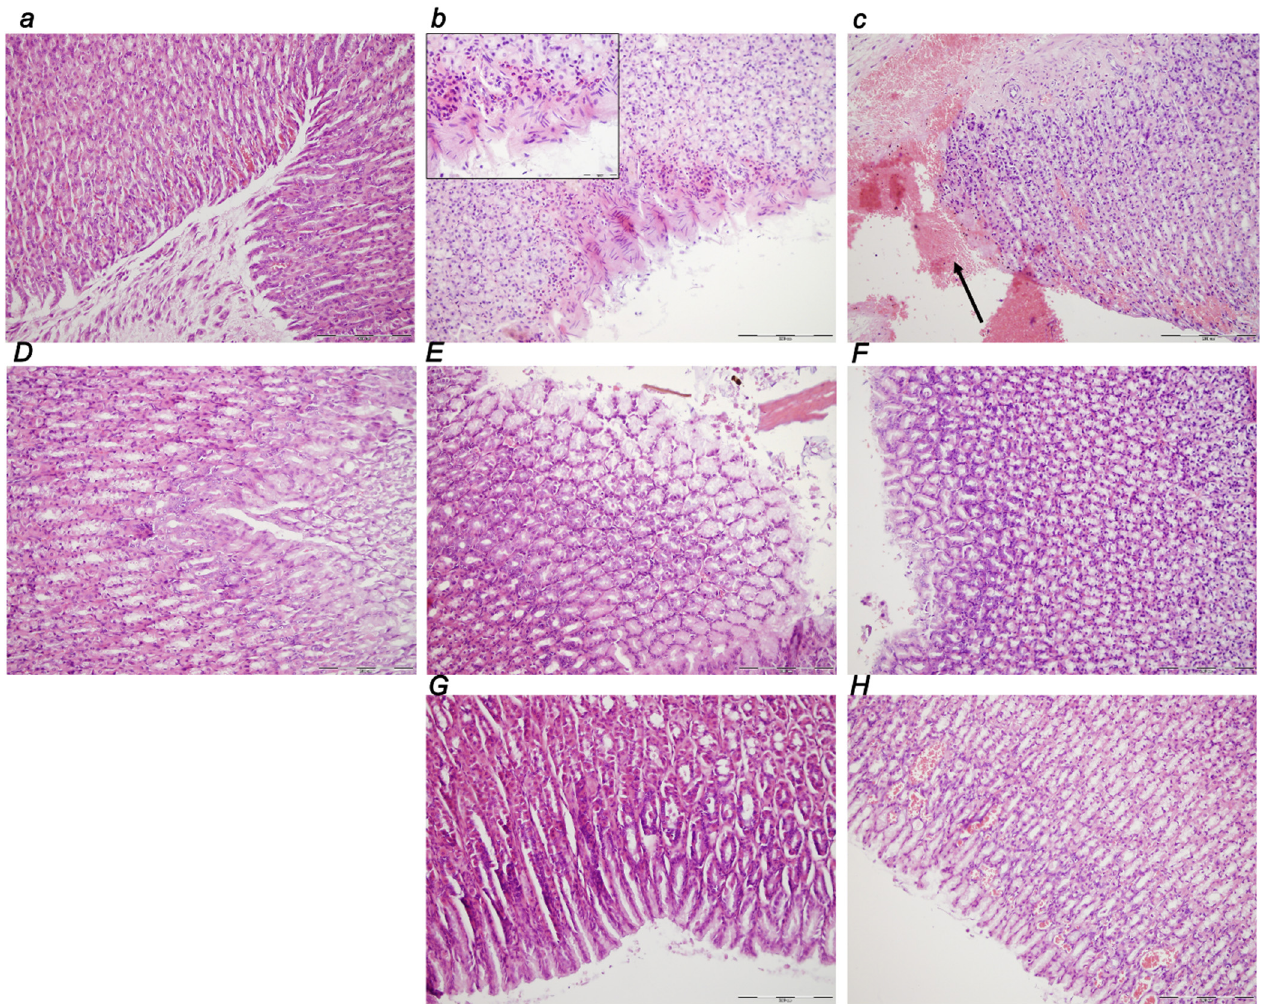
Figure 11. Stomach tissue damage illustrative microscopic presentation (HE staining; magnification 100×; scale bar 200 μ m) in rats with obstructed bile duct ( a – H ) at the end of the ligation time periods of 30 min, 5 h, and 24 h; as an early regimen at 0–30 min ( a , D ), 0–5 h ( b , E ), and 0–24 h ( c , F ) application sacrifice period; and as delayed regimen at 4.30 h–5 h ( G ) and 5 h–24 h ( H ) application sacrifice period in controls ( a – c ) and BPC 157-treated rats ( D – H ). In controls, marked congestion of the stomach wall at 30 min ( a ), 5 h ( b ), and 24 h ( c ) ligation time was observed, along with hemorrhagic erosions (black arrow) and intramucosal neutrophilic inflammatory infiltration (rectangular marked area; magnification 400×; scale bar 50 μ m) noted at 5 h and 24 h. In the BPC 157 early regimen ( D – F ), no changes appeared at 30 min ( D ), 5 h ( E ) and 24 h ( F ) ligation time. In the